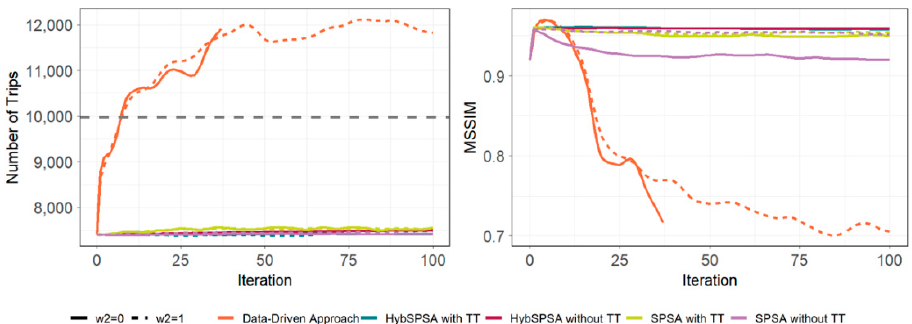
Figure 5. Number of trips and the MSSIM evolution during the optimization procedure.